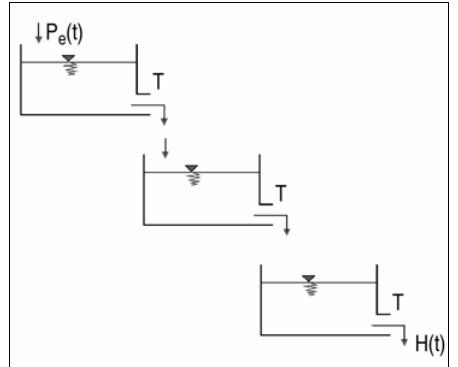
Fig 2 . Scheme of Nash model (the cascade of N linear reservoirs of constant moments